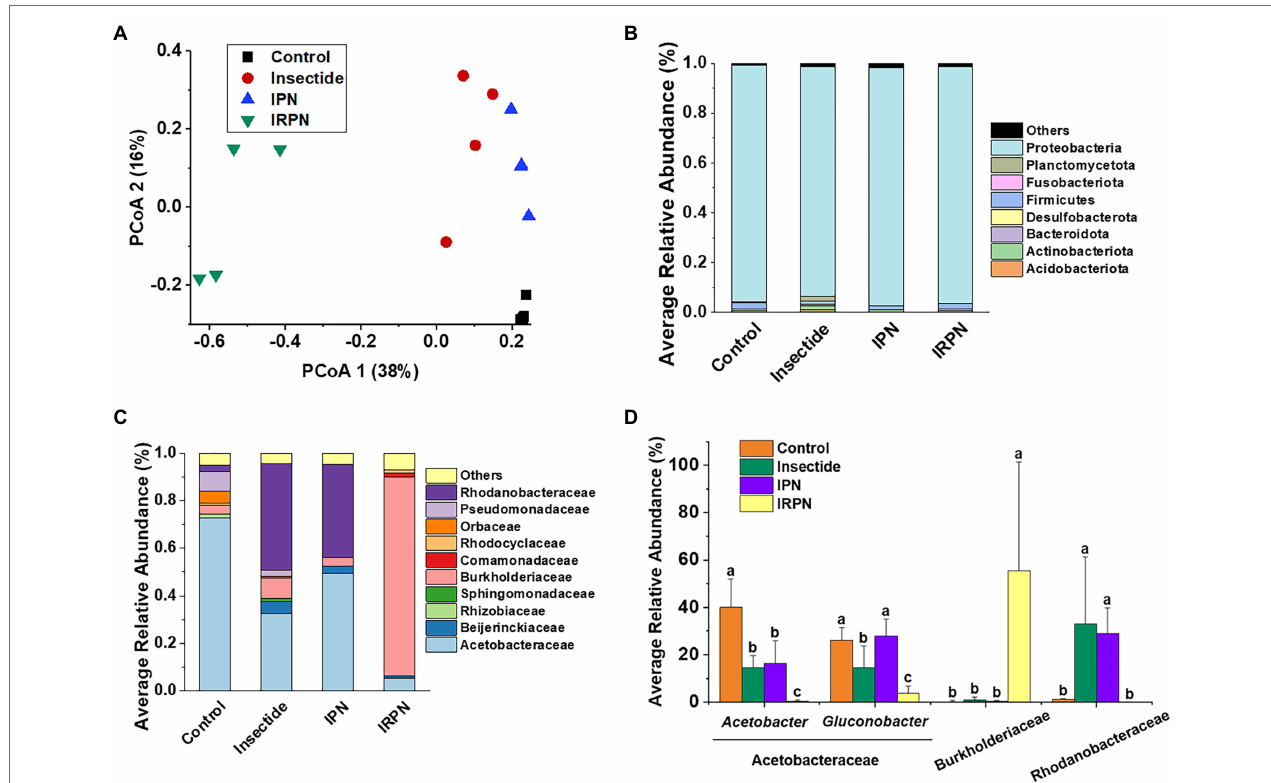
FIGURE 5 | Distribution of the dominant taxa of the bacterial communities. (A) Principal coordinate analysis (PCoA) plots for visualising the unweighted UniFrac distance among the bacterial communities. (B) Relative abundances of bacterial phyla (%) (phylum level for bacteria) and (C) distribution of families (%) affiliated with the phylum Proteobacteria in the Chinese bayberry trees that underwent different treatments. (D) Average abundances of key genera (phylum Proteobacteria) in Chinese bayberry grown in different planting environments